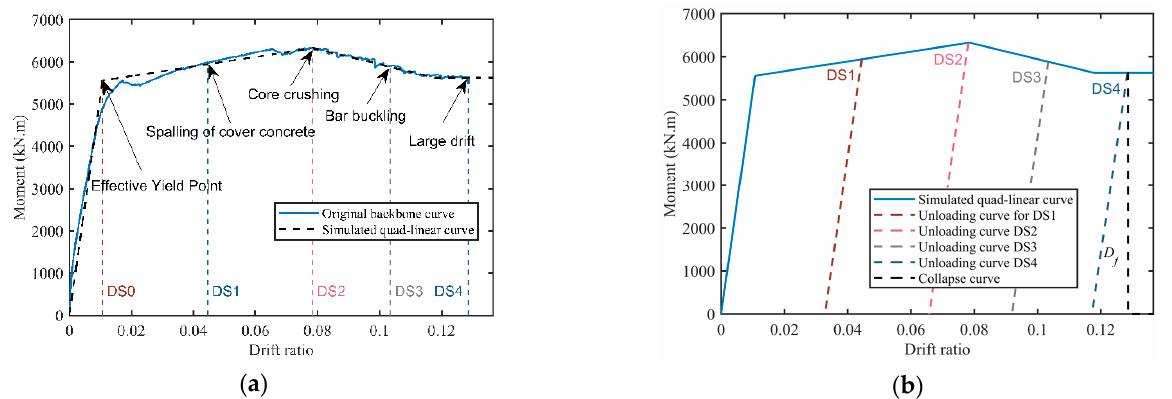
Figure 10. ( a ) The pushover curves for the study case, and ( b ) the definition of damage states in terms of Maximum Drift ratio and MBDI.